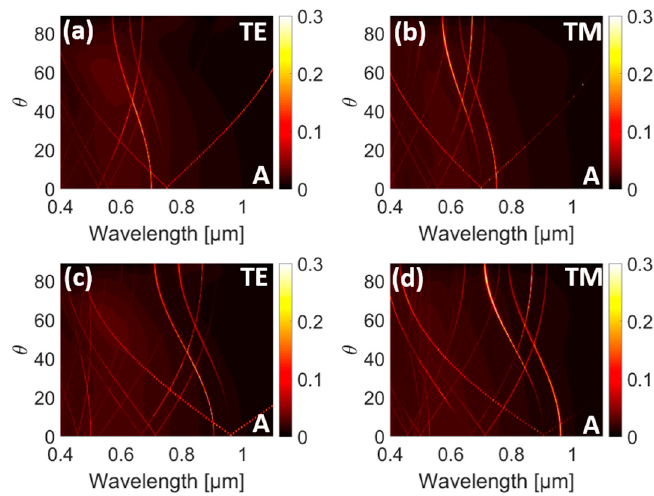
Figure 7. Absorption maps of the device for varying incidence angle (0–90°) under both TE and TM polarizations. For ( a , b ) device period p, the waveguide Ta 2 O 5 thickness t Ta2O5 , and PMMA pillars height t PMMA are fixed at 450 nm, 150 nm, and 600 nm, respectively, whereas, for ( c , d ) the period p is changed to 600 nm.